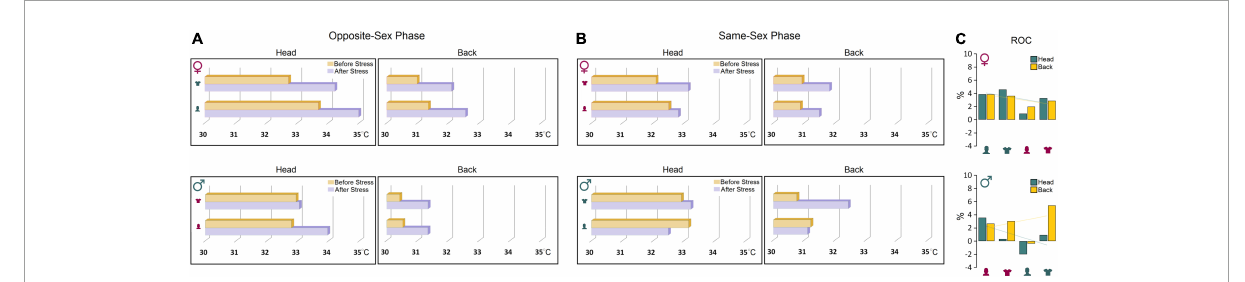
FIGURE4 (A,B) Thermal changes prior to and after stress. Both groups were susceptible to the stress procedure in the presence of opposite-sex experimenters. However, female thermal responses in both ROIs were noticeably different from males before and after stress indicating higher vulnerability of females to the impact of stress and experimenter sex. (C) The rate of changes (ROC) provides further support for exacerbated thermal responses in female rats to experimenter sex after stress relative to male rats. Note the trendlines of thermal changes in the head and back in both sexes that noticeably depict sex-specific differences in the regional thermal responses to stress and experimenter sex.